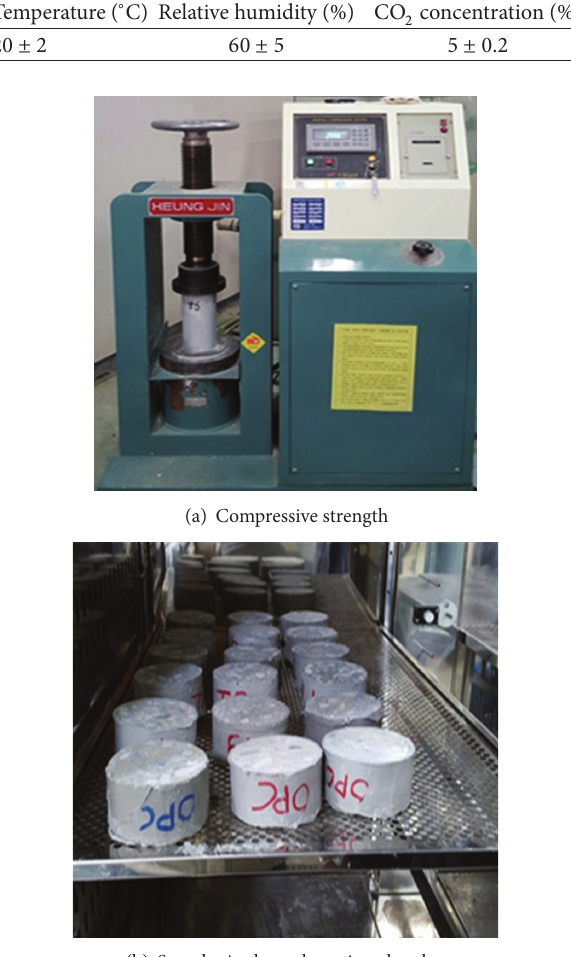
Table 3: Conditions for accelerated carbonation test.